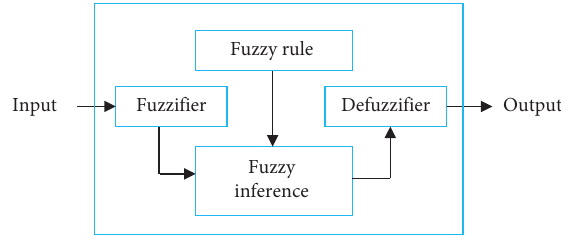
Figure 3: Basic configuration of a fuzzy logic system.